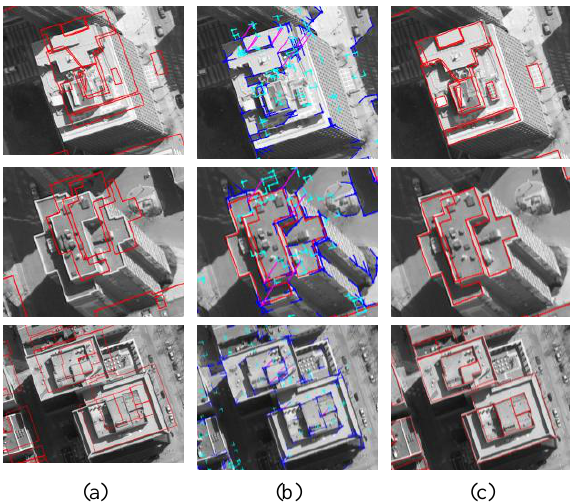
Figure 8. Results with LiDAR-driven building models: (a) with error-contained EOPs, (b) matching relations (magenta) between edged corner features extracted from the image (blue) and the models (cyan) and (c) with refined EOPs As quantitative evaluation, we evaluated RMSE of check points back-projected to the image space with refined EOPs (Table 2).